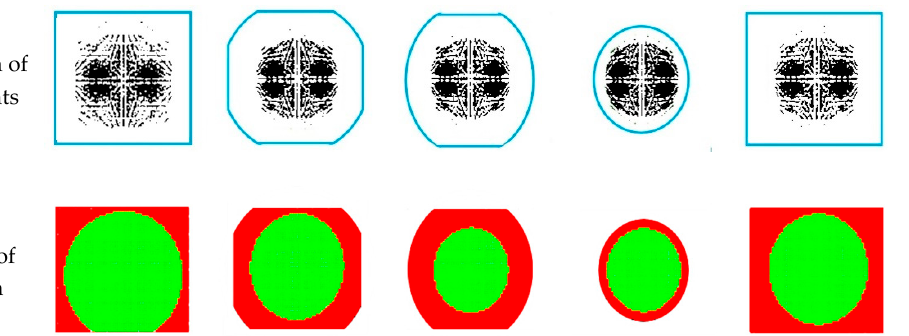
Figure 6. Image point distribution and residuals of distortion